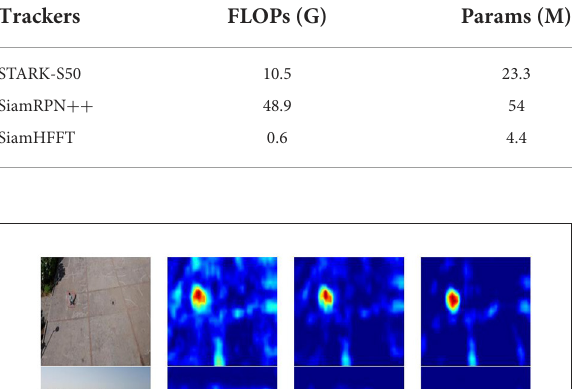
TABLE 5 Experimental results on UAV 123 benchmark with different